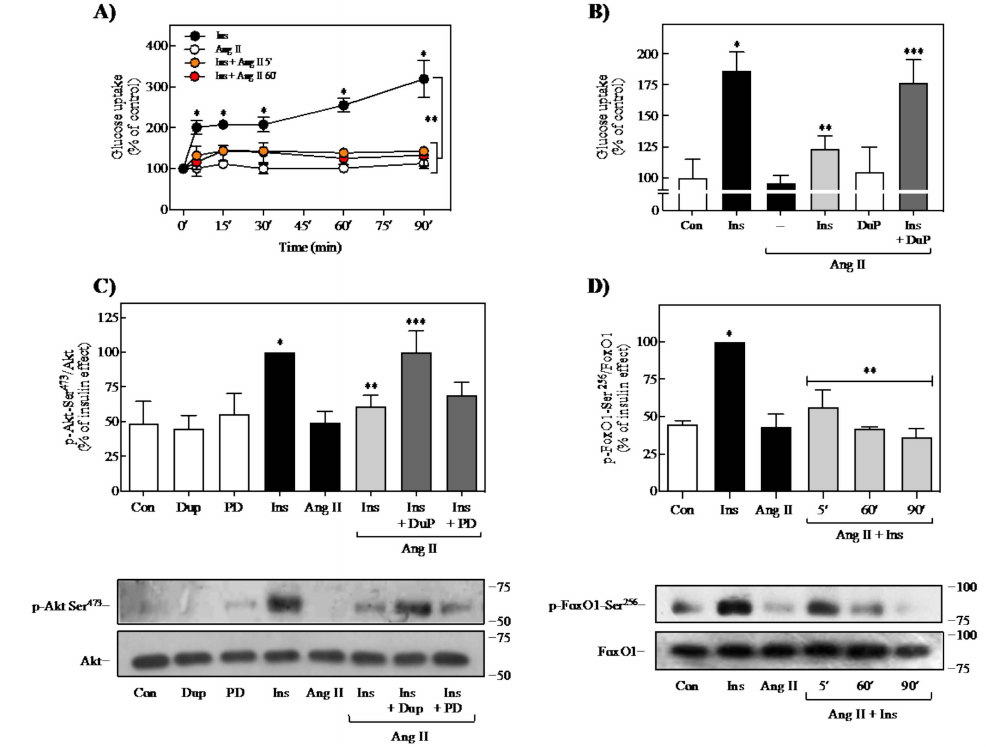
Figure 2. Effect of Ang II on insulin-induced glucose uptake and FoxO1 phosphorylation. ( A ) 3T3-L1 adipocytes were stimulated with 100 nM Ang II for the indicated times (white circles) or pretreated without (black circles) or with 100 nM Ang II for 5 (orange circles), or 60 min (red circles), and then stimulated with 100 nM insulin for the indicated times. ( B ) Cells were pretreated with 10 µ M DuP 753 for 30 min before treatment with 100 nM Ang II for 60 min and then stimulated with 100 nM insulin for an additional 90 min. Glucose uptake was determined as described in Methods. ( C ) Cells were pretreated with or without 10 µ M DuP 753 or 10 µ M PD123177 for 30 min, then were stimulated with or without 100 nM Ang II for 60 min. Finally, the cells were stimulated with or without insulin for 90 min. ( D ) Adipocytes were pretreated with 100 nM Ang II for 5, 60, or 90 min, and then stimulated with 100 nM insulin for 90 min. Total cell lysates were separated by SDS-PAGE and analyzed by immunoblotting with anti-p-Akt Ser 473 ( C ) and anti-p-FoxO1 Ser 256 ( D ). Under all experimental conditions, cells without treatment were considered as controls. Blots were quantitated by densitometry, and the mean values were plotted from three-independent experiments. Vertical lines represent the S.E.M. Representative immunoblots are presented. Western blots were also probed to detect total Akt ( C ), and FoxO1 ( D ) and used for data normalization. ( A ) * p < 0.05 vs. time 0 (cid:48) ; ** p < 0.05 vs. similar times stimulated only by Ins. ( B , C ) * p < 0.05 vs. Con; ** p < 0.05 vs. Ins; *** p < 0.05 vs. Ins + Ang II. ( D ) * p < 0.05 vs. Con; ** p < 0.05 vs. Ins. Con, control; DuP, DuP 753; PD, PD123177; Ins,